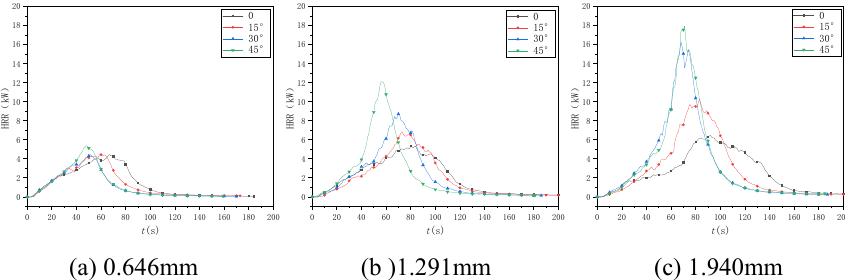
Fig. 4. Change of Heat Release Rate at different initial